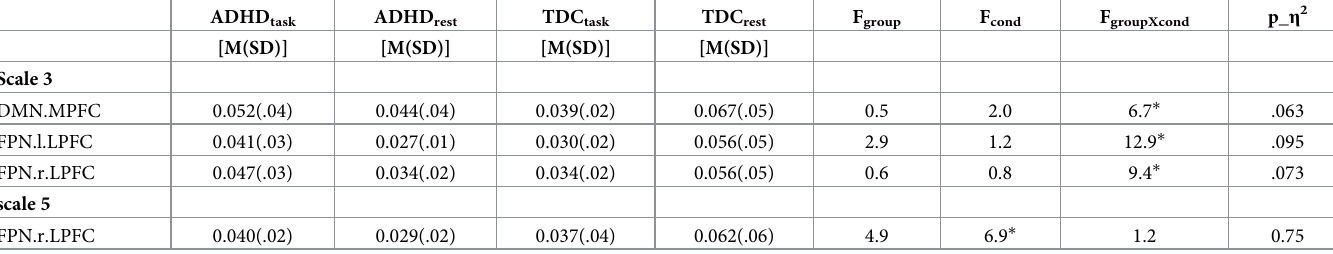
Table 1. Significant results of 2x2 MANOVA models using condition and group and ROI-and scale-specific wVar. ADHD task ADHD rest TDC task